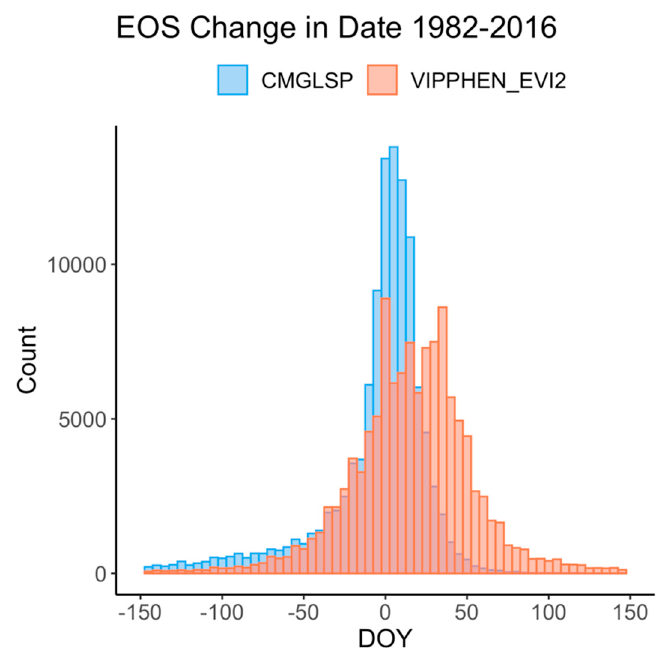
Figure A7. Histogram of CMGLSP and VIPPHEN_EVI2 EOS change in date from 1982 to 2016.